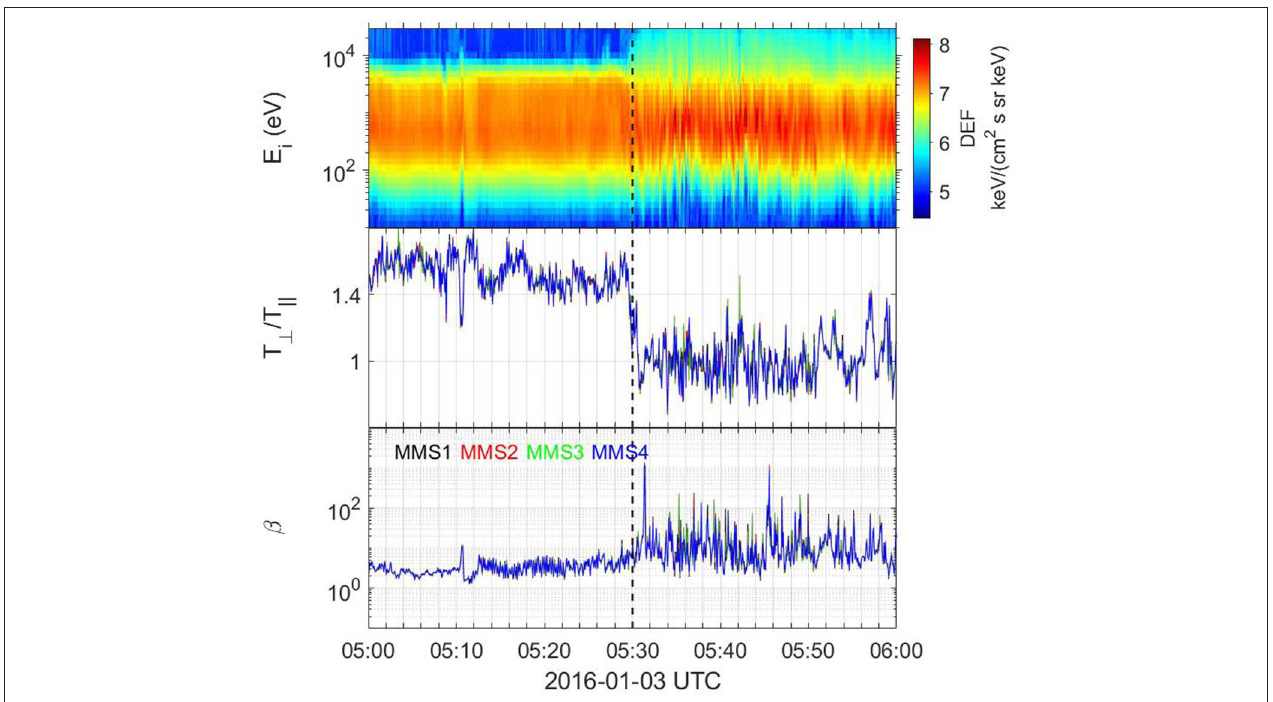
FIGURE 1 | Top to bottom: Differential energy flux for ions for MMS4, temperature anisotropy in perpendicular and parallel directions to the background magnetic field, and plasma beta for MMS1-4. The vertical black dashed line marks the transition between the Q ⊥ MSH (left) to the Q || MSH (right)